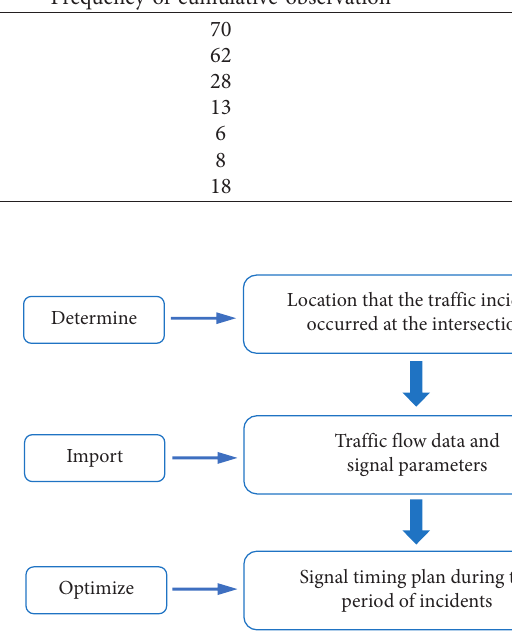
Figure 2: The flowchart of signal timing optimization affected by traffic incidents.